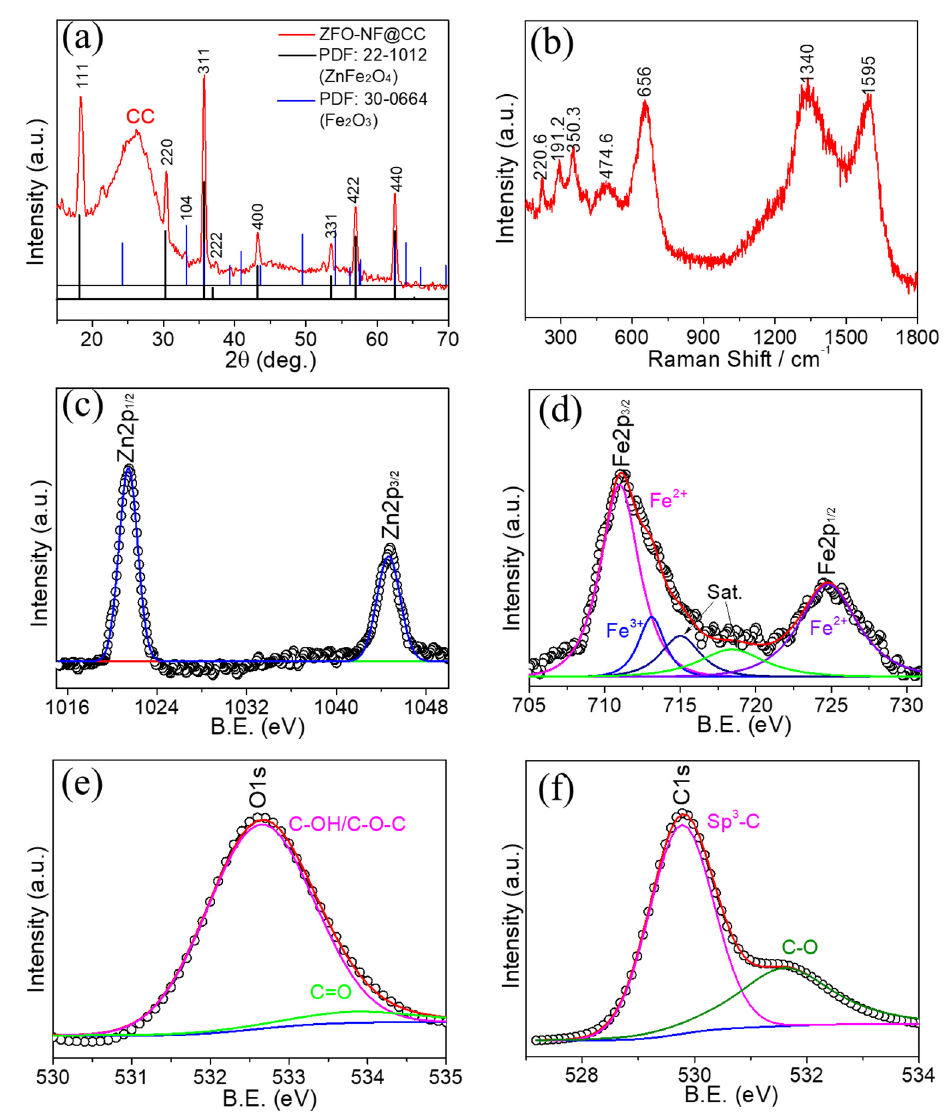
Figure 4. ( a ) XRD pattern; ( b ) Raman spectra; XPS principal spectra of ( c ) Zn 2p, ( d ) Fe 2p, ( e ) O 1s, and ( f ) C 1 s for of ZnFe 2 O 4 nanoflakes at CC.